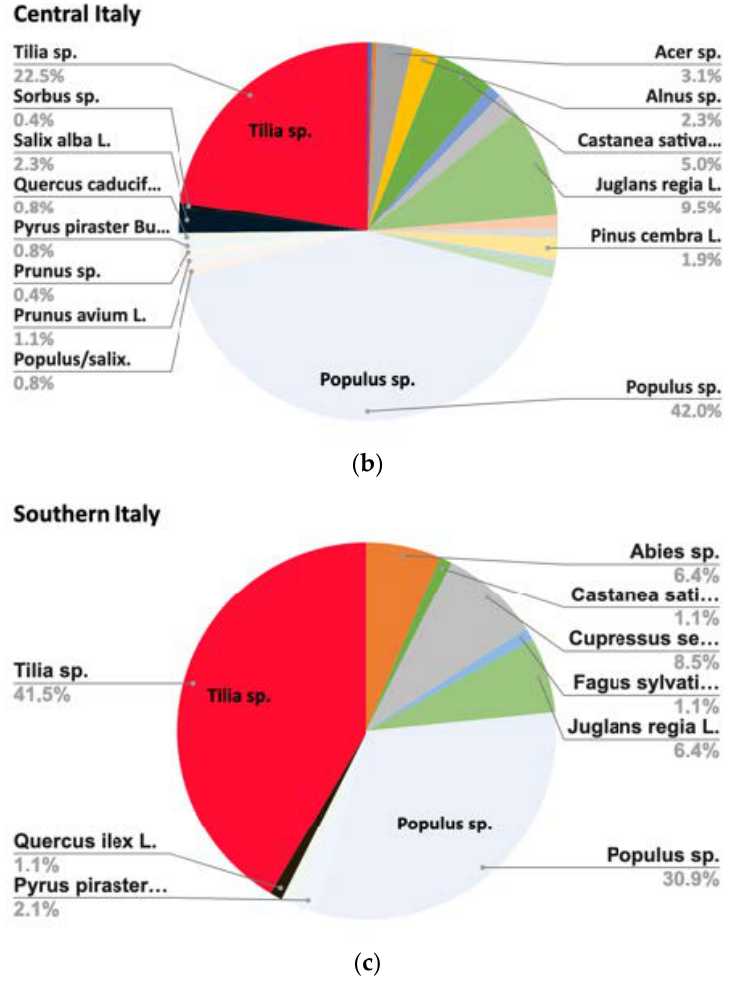
Figure 5. Timber distribution in carved artworks in Italy: northern ( a ), central ( b ), and southern ( c ).